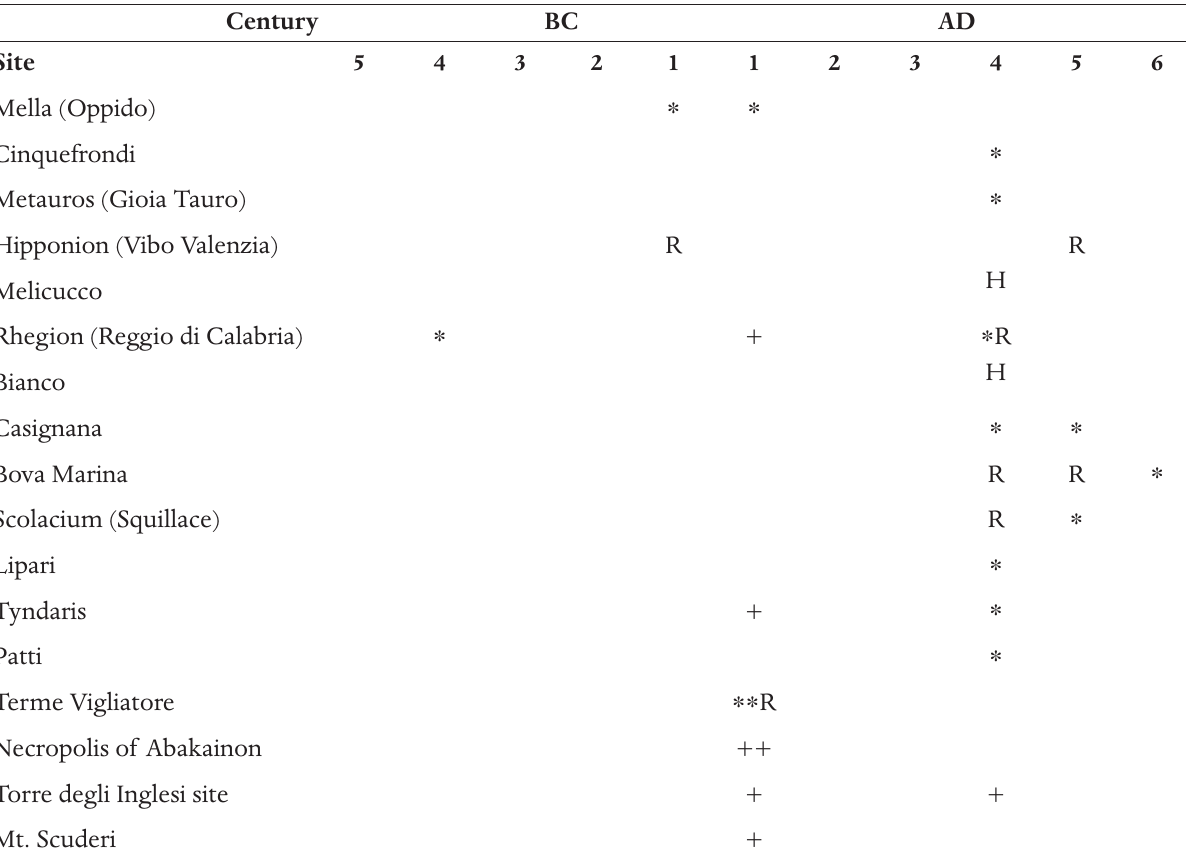
Table 4. History of archaeological sites in southern Calabria and northeastern Sicily. Asterisks indicate the destruction phase; H indicates the presence of hoards; R are restoration/reconstruction phases;+indicates information gathered in this work. ** reconstruction phase ac- cording to Tigano et al. [2008]; ++evidence of destruction from Bottari et al. [2013]. Note the concentration of destruction/restoration and hoards in the latter half of the 4th century AD modified from Galli and Bosi